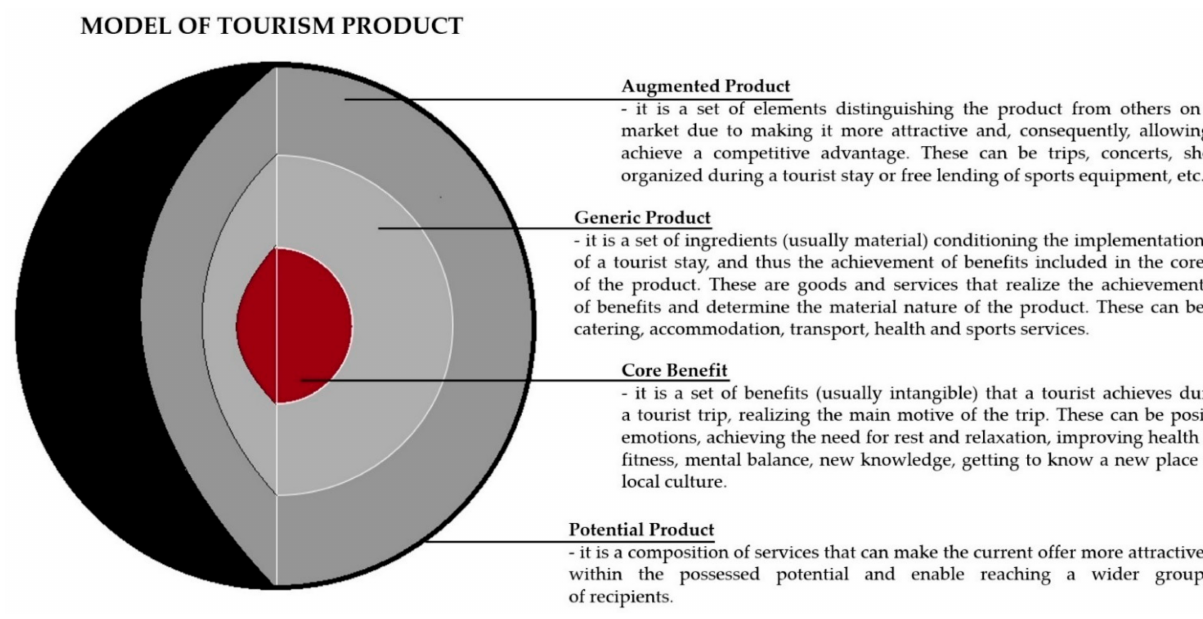
Figure 1. The atomic structure of a tourist